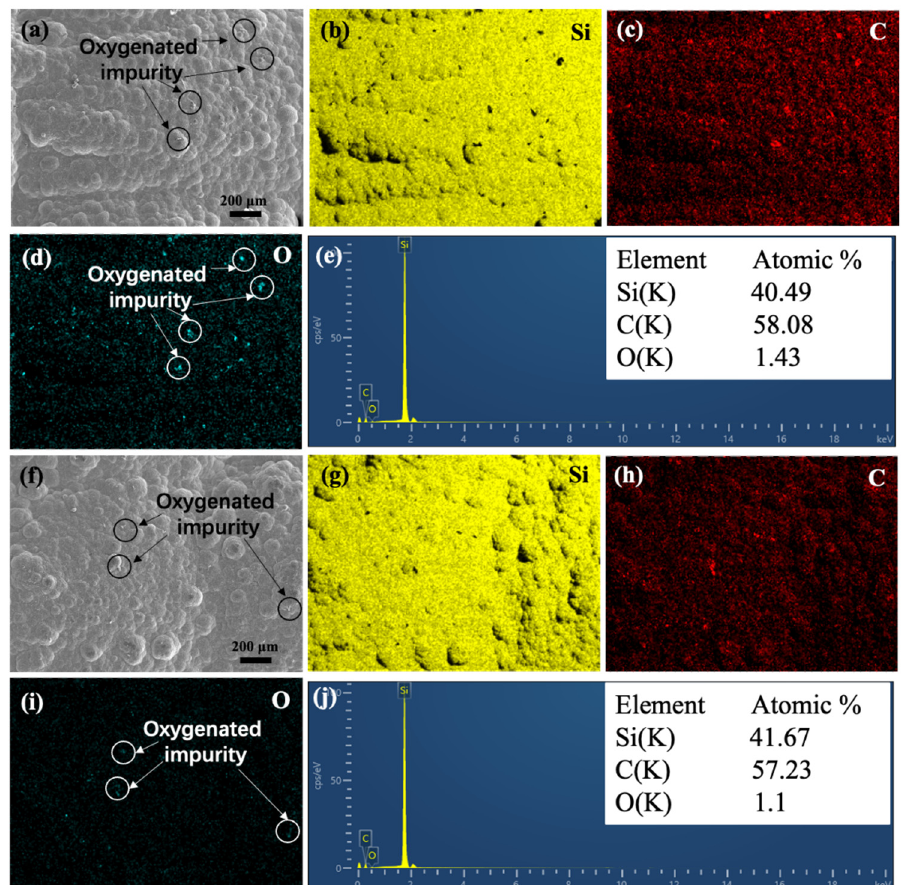
Figure 9. ( a ) sample E-2, ( b – d ) corresponding elemental mapping of Si, C and O, ( e ) corresponding EDX spectra and the atomic ratio of sample E-2, ( f ) sample AD-3, ( g – i ) corresponding elemental mapping of Si, C and O, ( j ) corresponding EDX spectra and the atomic ratio of sample AD-3.